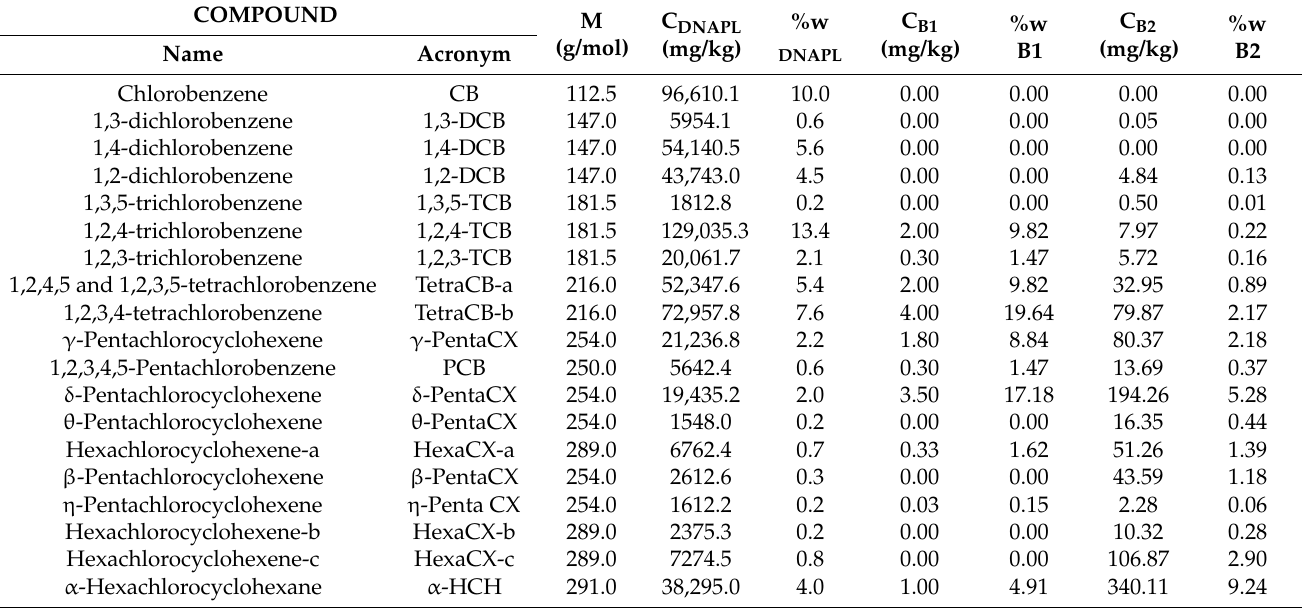
Table 1. COCs composition of DNAPL and soil